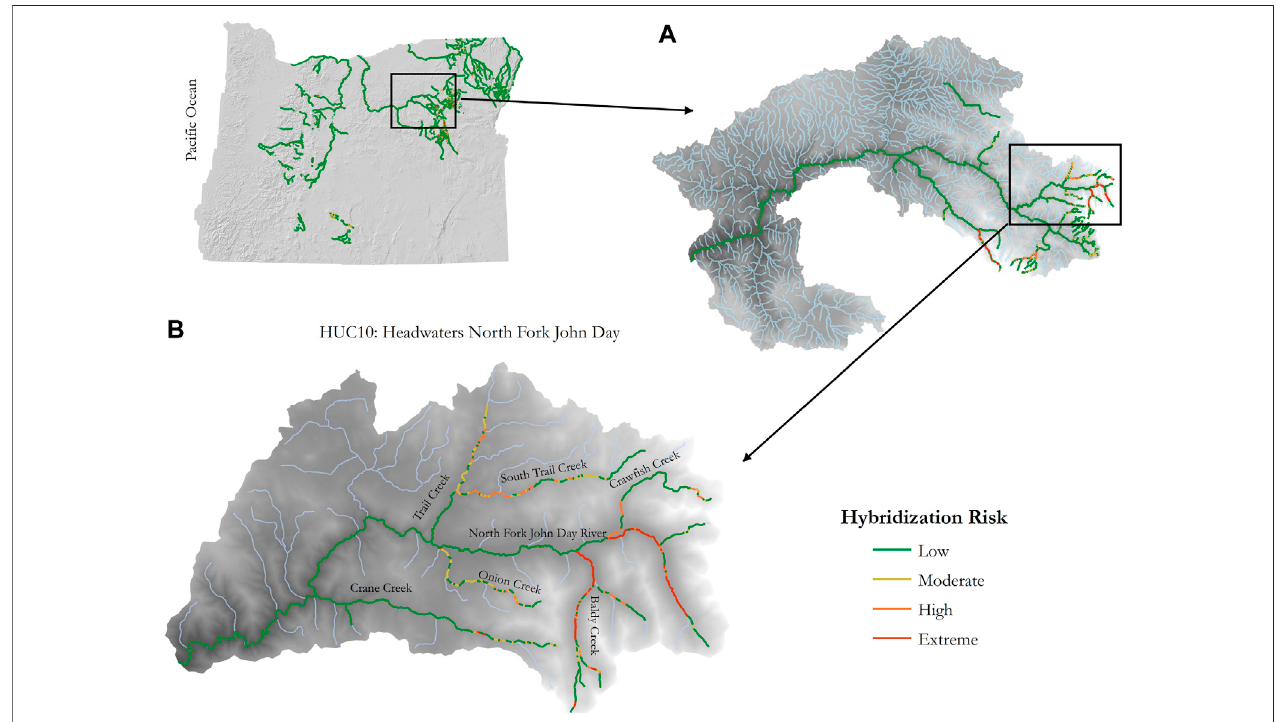
FIGURE8| Hybridizationriskmapsatthestate,sub-basin,andwatershedscales (A) and (B) . (A) TheNorthForkJohnDaysub-basin(HUC8),and (B) Headwaters of the North Fork John Day (HUC10). This is an illustrative example of the HRM applied to multiple spatial scales (spatial resolution includes 100 m river segments).